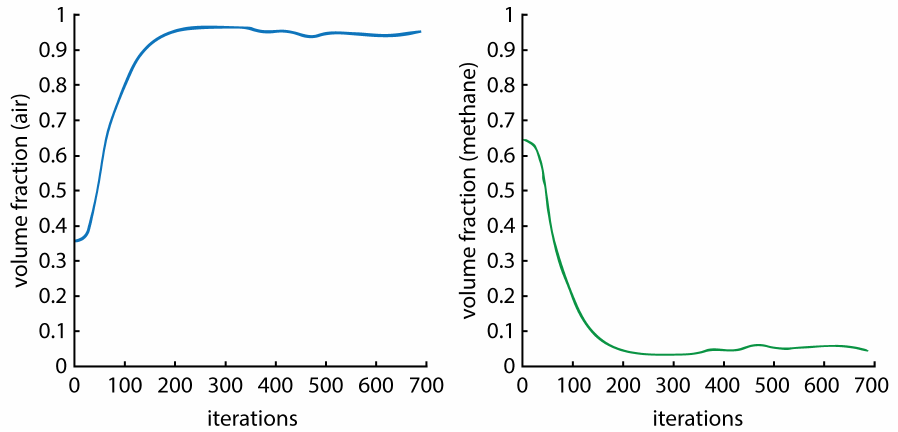
Figure 14. Volume fraction of air, converging to 0.95 ( left ) and volume fraction of methane, converging to 0.05 ( right ) in Solidworks Flow